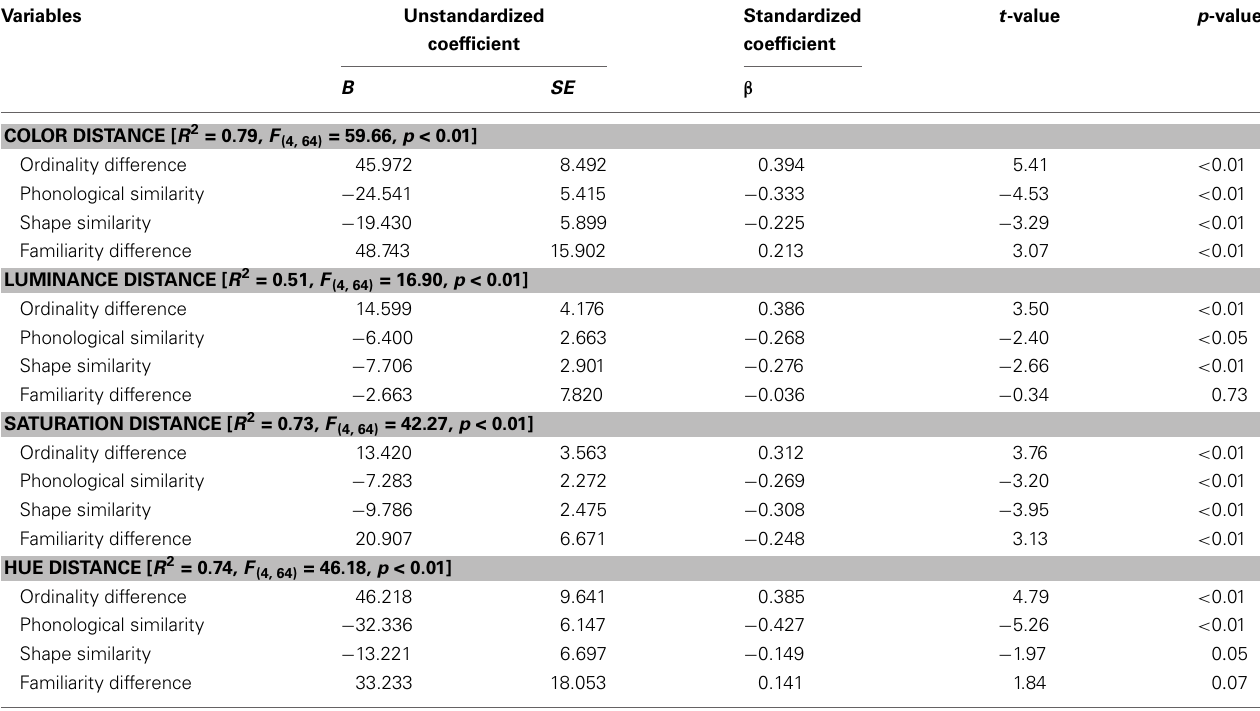
Table 2 | Results of multiple regression analyses for Hiragana character pairs.